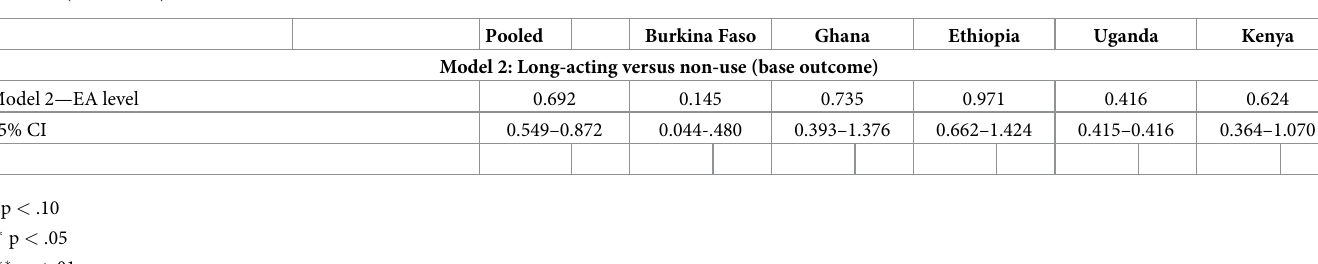
Burkina Faso and for short- versus long-acting method use in Ghana (Table 5). The type of facility appeared most often to be significantly associated with a woman’s use of short- or long-acting contraception. Positive AMEs were observed for other facility factors but only with occasional statistical significance. In particular, mean number of long-acting methods offered was significantly associated with long-acting versus no method use overall (0.012, p < .05) and only borderline significant in Burkina Faso, although negative (-0.039, p < .10) (Table 4), and for the comparison of a short- versus long-acting method overall (0.008, p < .10) and in Ghana (0.035, p < .10) (Table 5). At the individual level, age was associated with short-acting contraceptive use in the major- ity of countries, although the relationship varied across countries (Table 3). Generally, women age 20–44 were significantly more likely to use short-acting contraception than women age 15–19, while women age 45–49 were significantly less likely to be using contraception in all countries and in the pooled estimates (-0.070, p < .01) (Table 3). Age was less associated with long-acting versus no contraceptive use (Table 4) but older age women favored long- versus short-acting methods (Table 5). Education was positively and significantly associated with contraceptive use across all three models in most countries (Tables 3, 4 and 5). In all countries, increased parity was significantly and positively associated with use of short-acting and long- acting contraceptive use (Tables 3, 4 and 5). Increased wealth was generally positively associ- ated with short-acting contraceptive use overall and in Ethiopia and Uganda (Table 3), and long-acting contraceptive use overall and in Uganda and Kenya (Table 4), while the relation- ship was not statistically significant for the choice between a long- and short-acting method (Table 5). The random effects parameter for the EA was statistically significant in all countries and in the pooled model for all analyses, indicating that there were significant unobserved EA characteristics related to modern method use not captured in our models. However, the var- iability in use levels due to EA random effects was minimal. Inclusion of the country-spe- cific fixed effects in the pooled model show that, once adjusted for other factors, relative to Burkina Faso, women in Uganda, have similar individual probabilities of short-acting con- traceptive use while those in Kenya have similar probability of long-acting contraceptive use. Conversely, relative to women in Burkina Faso, women in Ethiopia and Kenya had sig- nificantly higher individual probabilities of short-acting contraceptive use (0.041, p < 0.01, 0.158 p < 0.01, respectively) and women in Ethiopia, Ghana, and Uganda had lower individ- ual probabilities of long-acting contraceptive use (-0.035 p < .05, -0.079, p < .01, and -0.078 p < 0.01, respectively) (Tables 3 and 4). Women in all countries were also significantly less likely to be using long-acting compared to short-acting contraception than women in Bur- kina Faso (Table